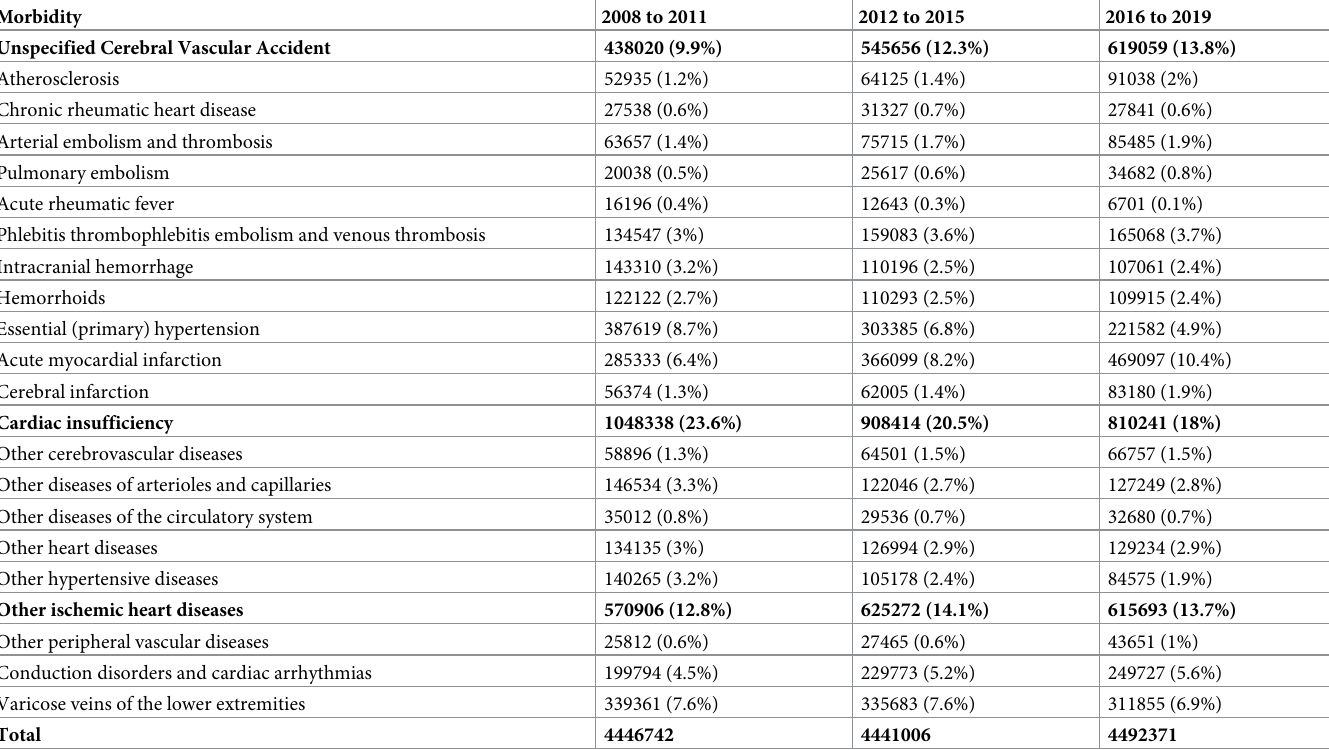
Table 1. Relative and absolute frequency of hospital admissions for cardiovascular diseases according to morbidity and quadrennium (2008 to 2011; 2012 to 2015; 2016 to